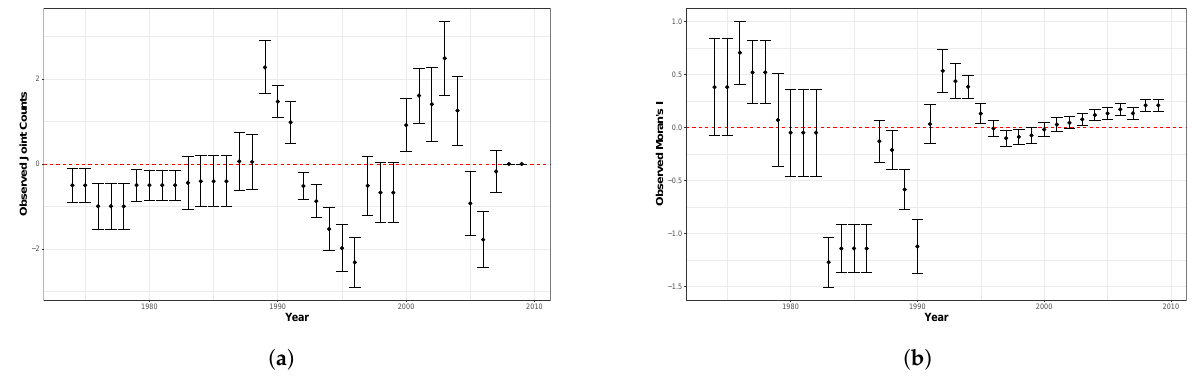
Figure A2. Results from the two autocorrelation diagnostics for the post-war peace duration applica- tion: ( a ) join count and ( b ) Moran’s